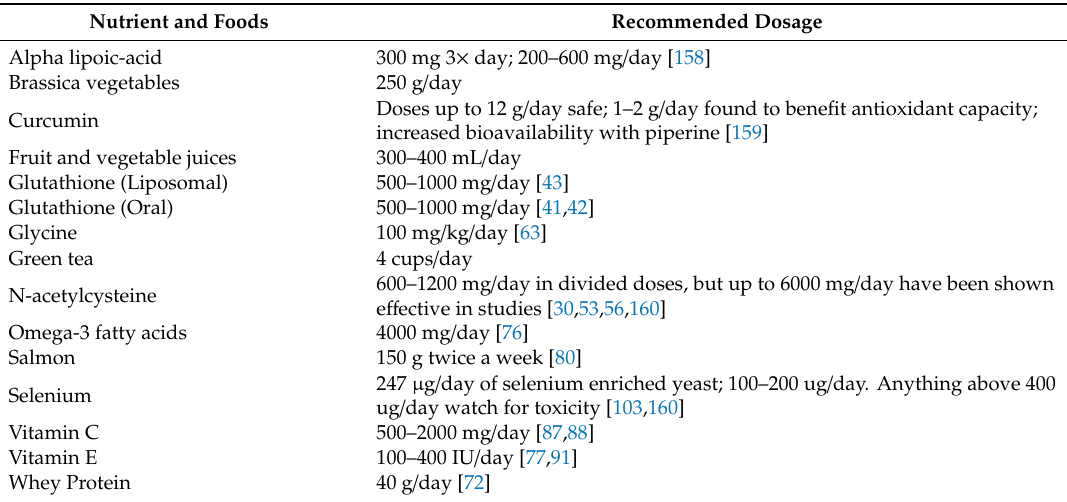
Table 4. Summary of nutrients and foods for support of glutathione